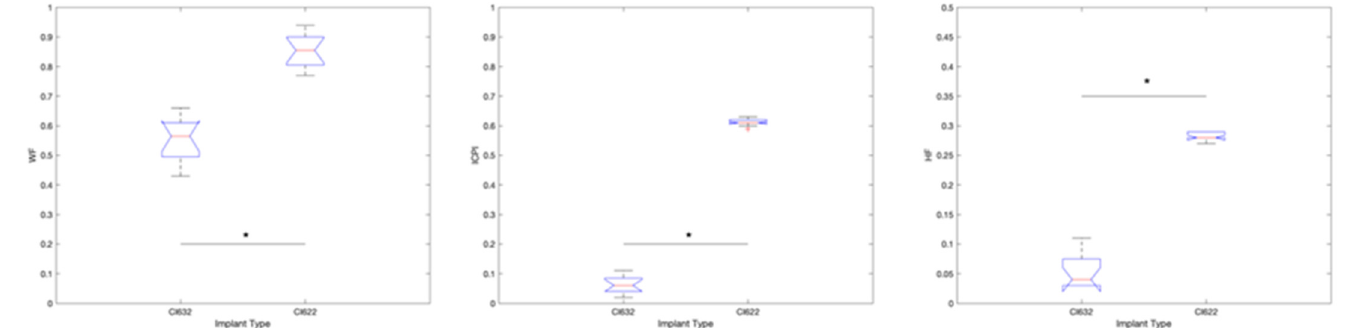
Figure 2. Radiological evaluation comparison chart between CI632 and CI622 recipients (* p < 0.05).